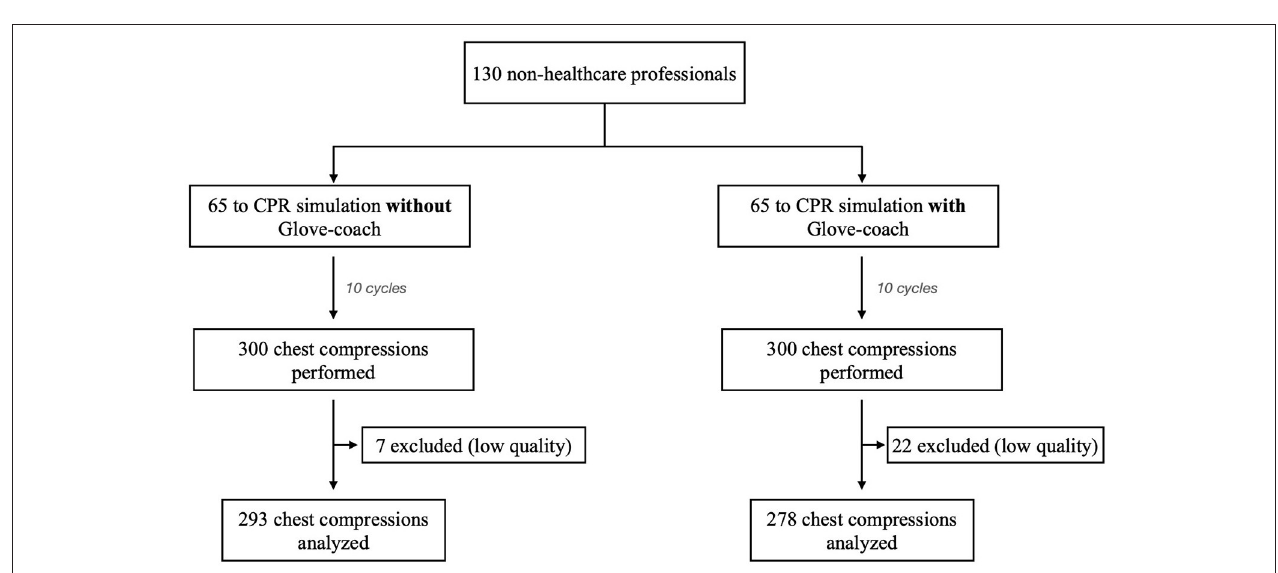
FIGURE 3 | CPR data distribution: patients and chest compression distribution according to CONSORT standard.